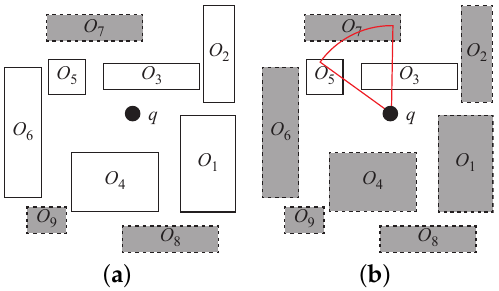
Figure 3. ( a ) Nearest surrounder query and ( b ) Angle-constrained Nearest Surrounder (ANS)